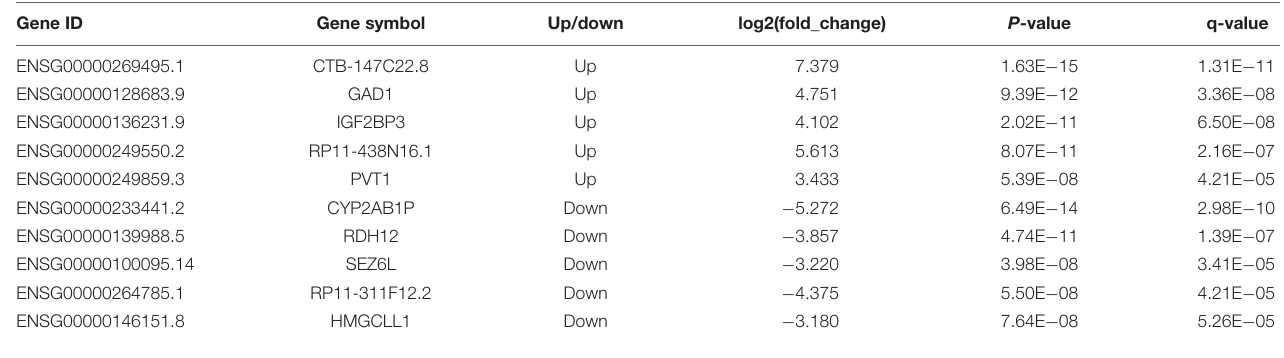
TABLE 2 | Typical up/downregulated lncRNAs in gastric